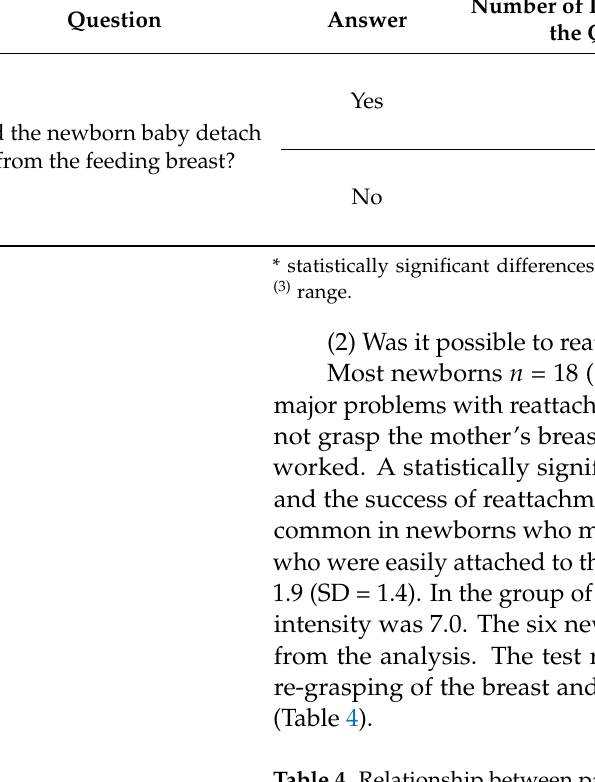
Table 4. Relationship between pain assessment and the answer to question no.